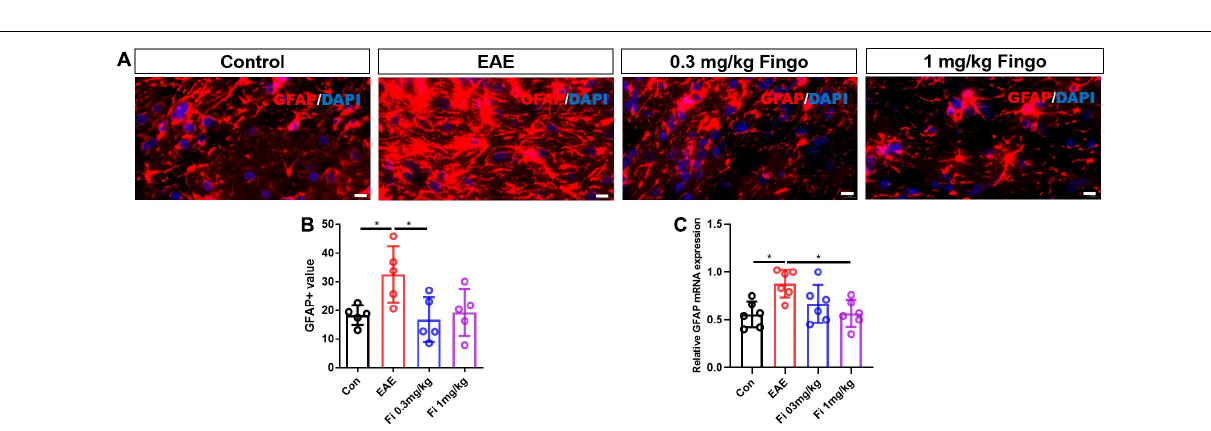
Frontiers in Neuroscience |